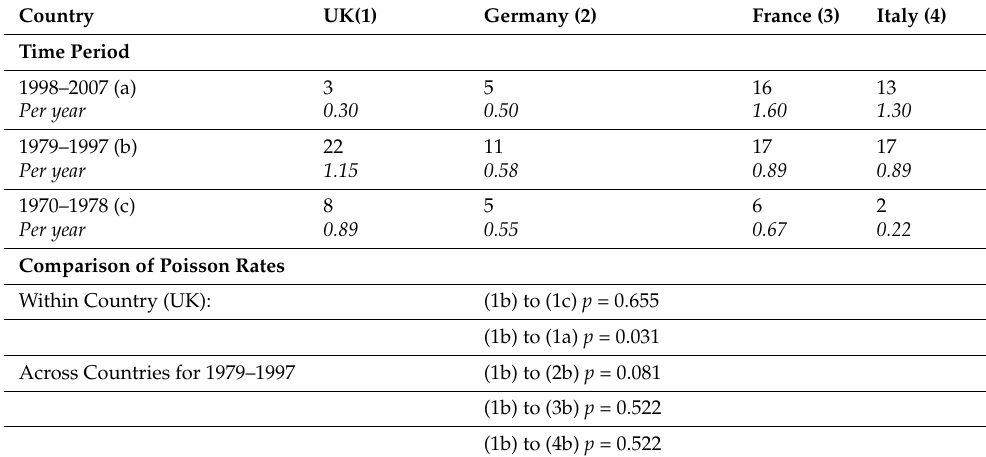
Table 3. Total and per Year Number of Multi-fatality Disasters (Excluding Air), 1970–2007. Country